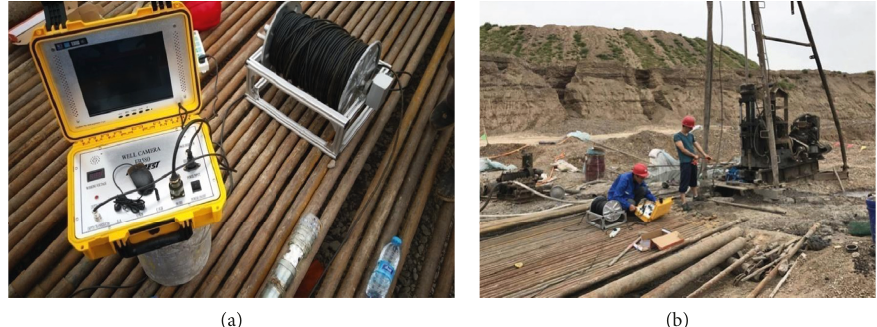
Figure 16: (a) FB580 borehole television; (b) construction site.